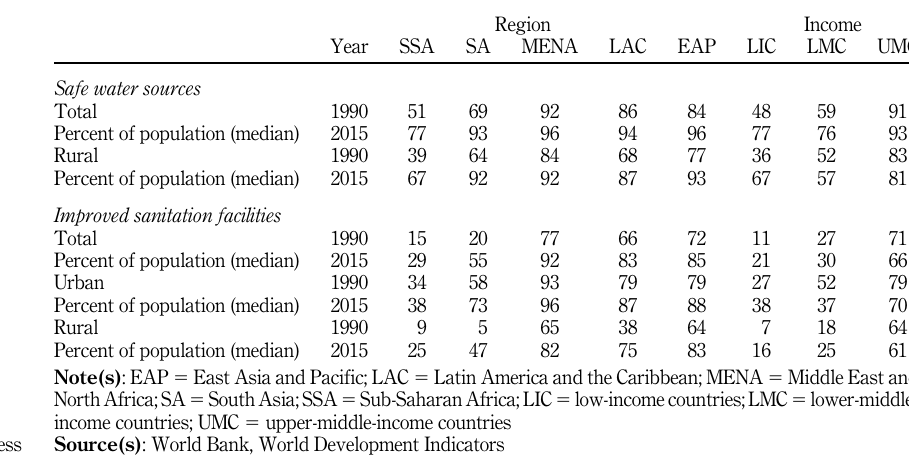
Table IV. Water supply and sanitation infrastructure access